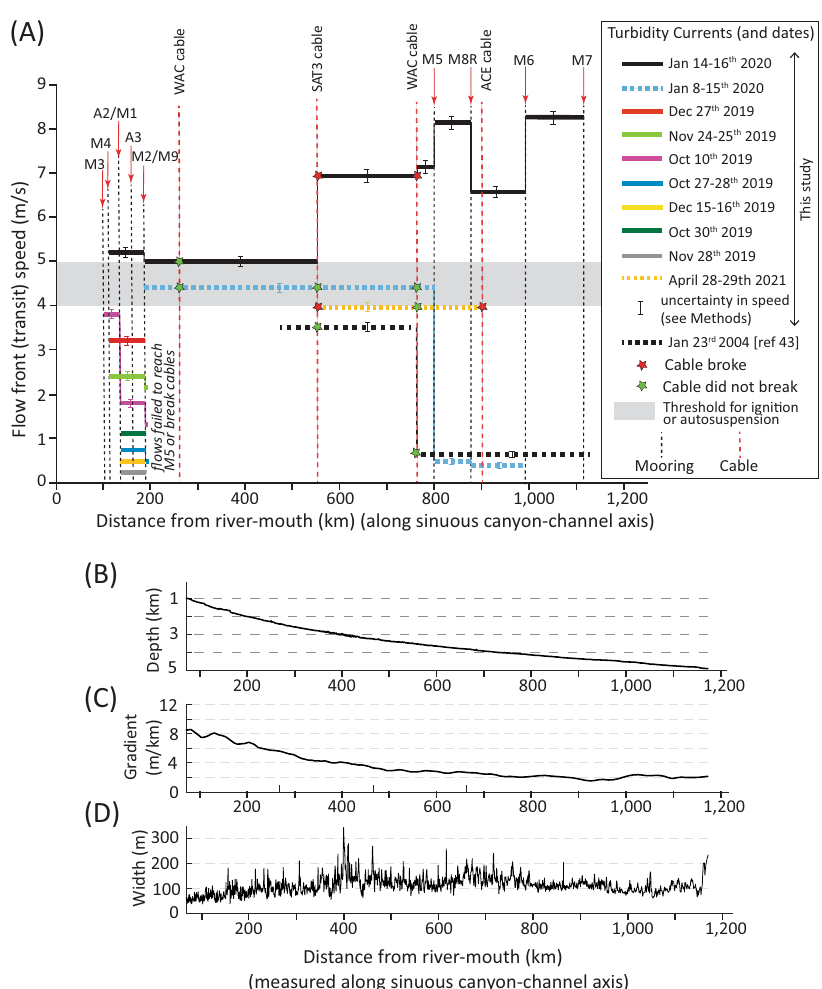
Fig. 5 Changes in turbidity current front (transit) speed with distance along the Congo Fan system, compared to changes in long pro fi le, gradient and width. A Changes in front speed with distance from Congo River mouth for all turbidity currents recorded in 2019 – 20. Flow speeds are derived from submarine cable breaks, and arrival times at moored ADCPs. Distances are measured along the sinuous fl oor of the Congo Canyon-Channel. Seabed cable are shown by vertical dashed lines, and ADCP-mooring (e.g., M7) sites are shown by red arrows and vertical dashed lines. Speeds of individual turbidity currents in 2019 – 2020 are shown by different coloured lines. The fi gure also includes the speed of the April 28 – 29th 2021 turbidity current between cable breaks (Supplementary Table 1), and the speed of a turbidity current between moorings in 2004 42 . Flows with front speeds >4 – 5 m/s (grey box) tend to self-accelerate or sustain those front speeds over long distance, while fl ows with front speeds <4 m/s tend to decelerate and dissipate. B Changes in water depth and C sea fl oor gradient with distance along the fl oor of the canyon-channel. D Changes in canyon-channel width with distance measured at crests of con fi ning levees or fi rst